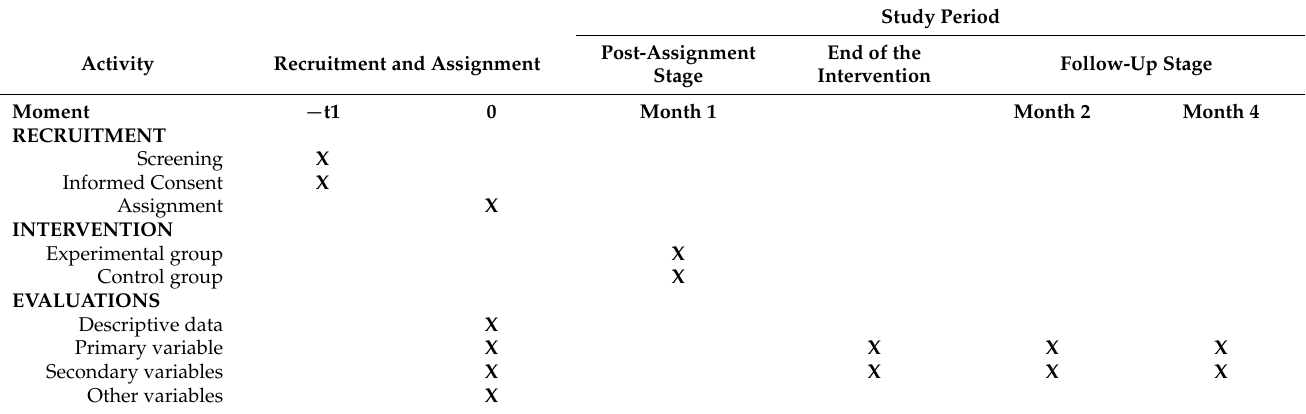
Table 1. Schedule of recruitment, interventions and